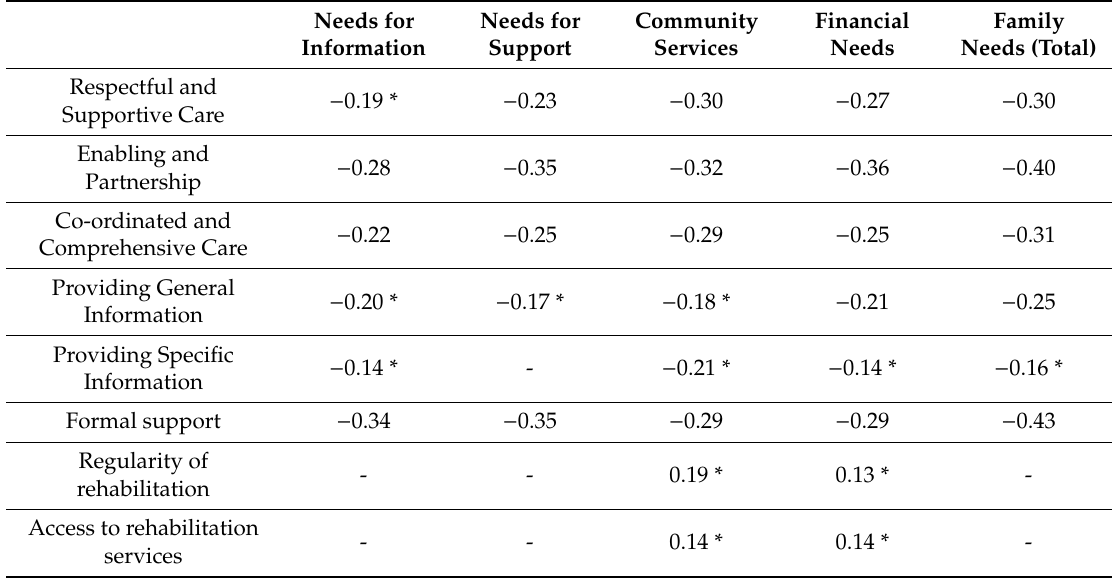
Table 10. Statistically significant correlations between family needs and service